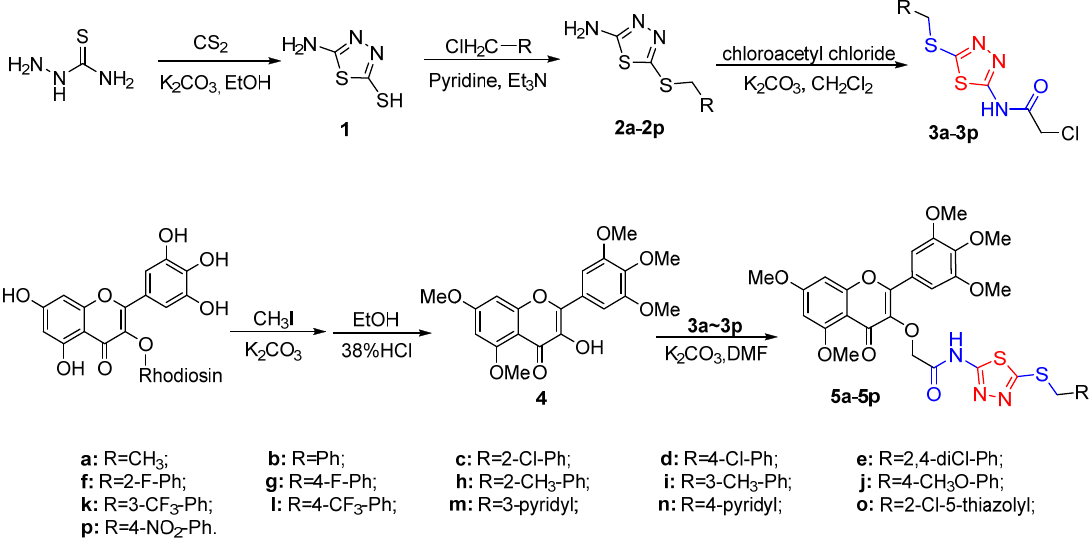
Scheme 1 Synthesis of the title compounds 5a − 5p. Scheme 1. Synthesis of the title compounds 5a – 5p .